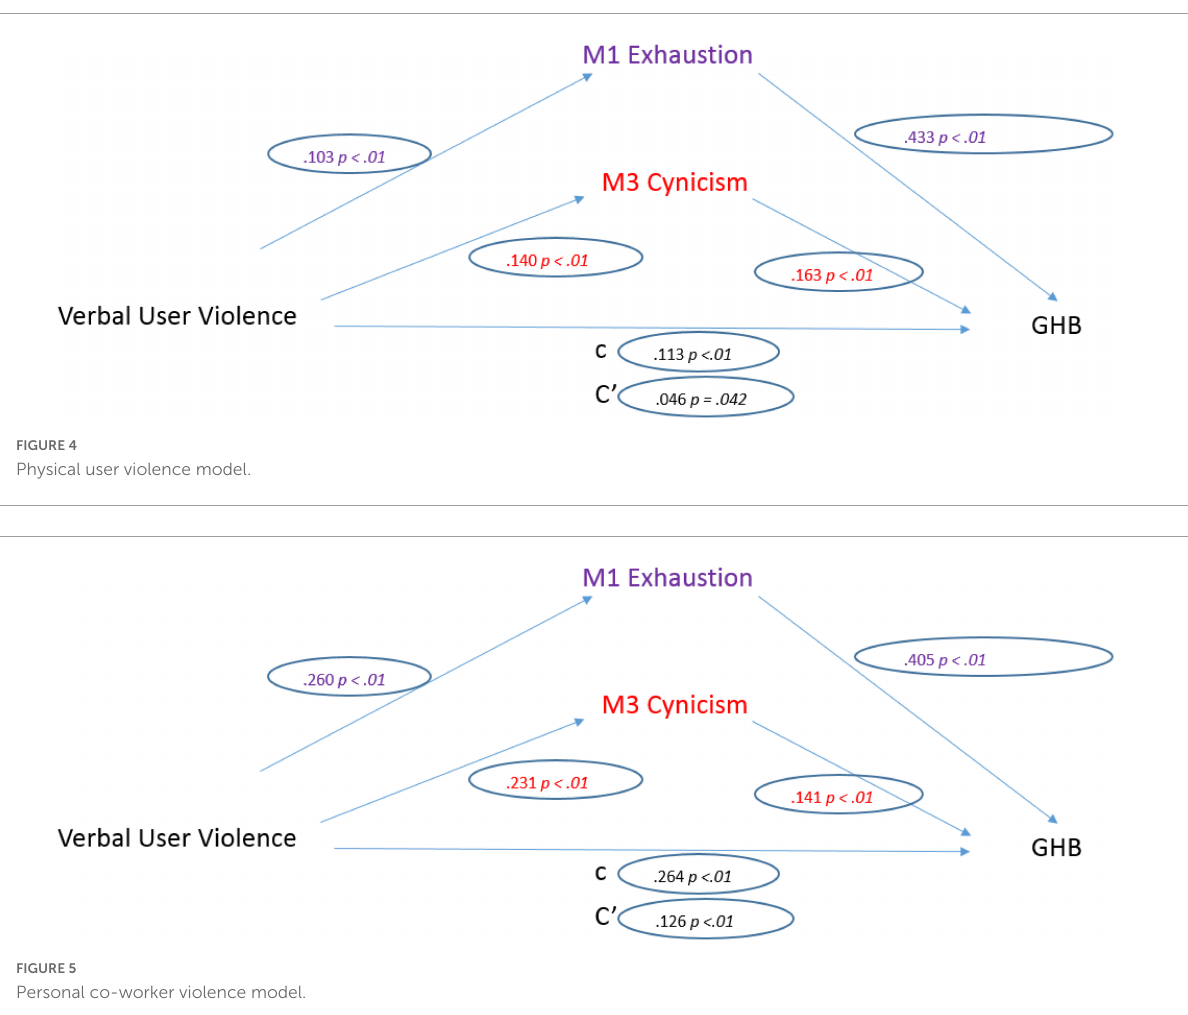
FIGURE5 Personal co-worker violence